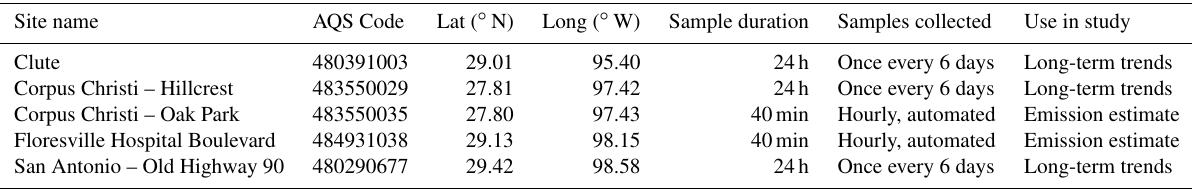
Table 1. Description of TCEQ sites used in this